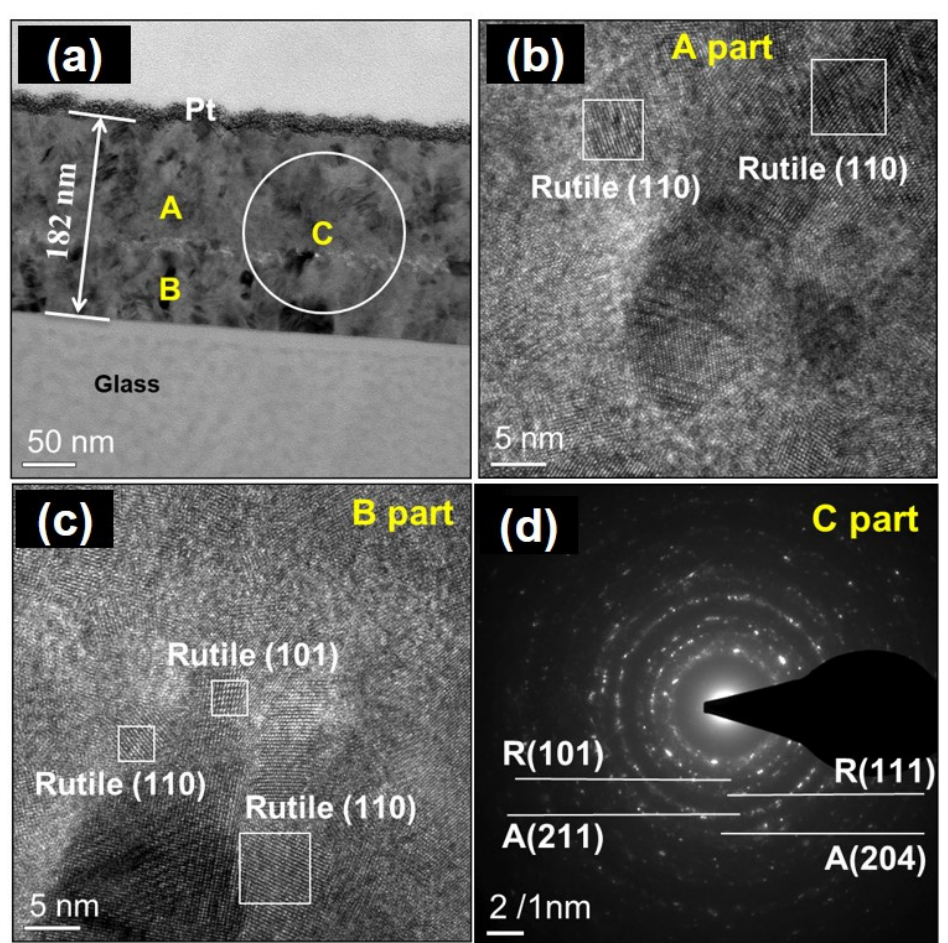
Figure 6. TEM micrographs of a sample 3 thin-film thermally oxidized at 450°C; ( a ) plane view of the film, ( b ) HR-TEM image showing point A, ( c ) HR-TEM image showing point B, and ( d ) NBED showing point C.